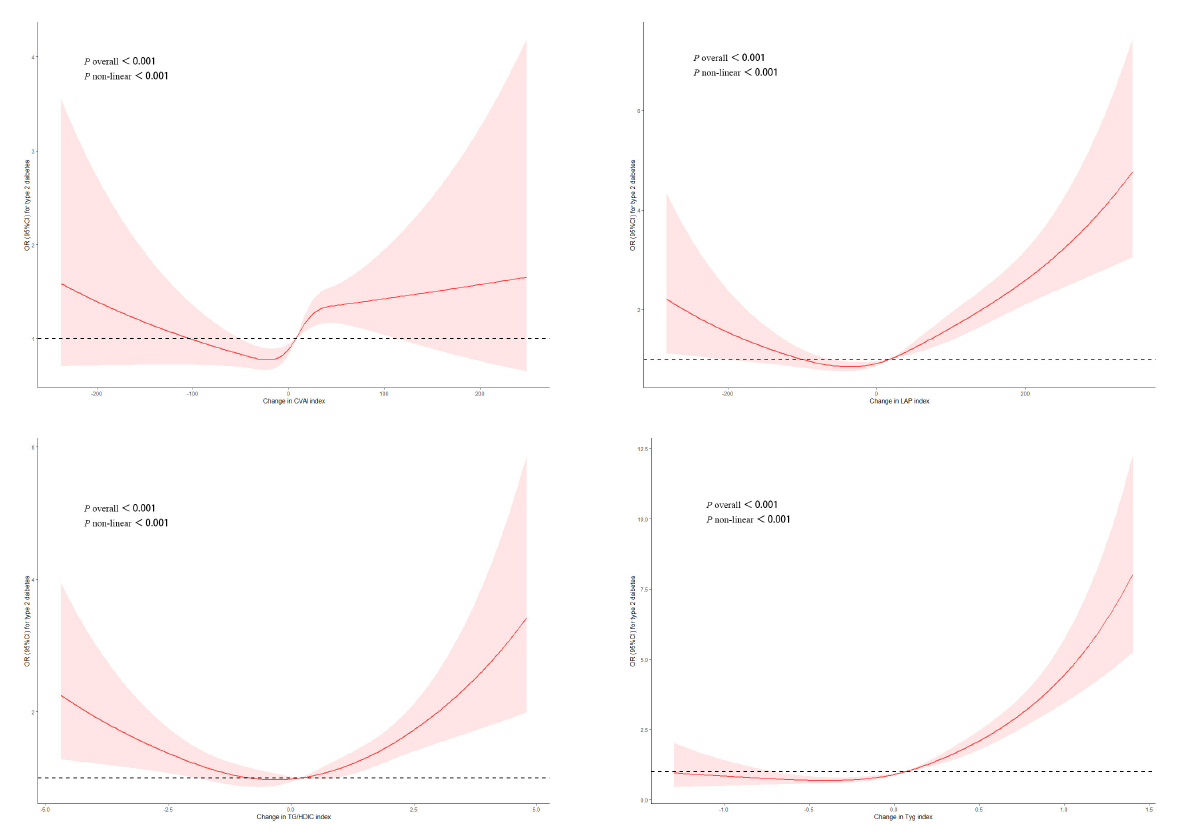
FIGURE1 Adjusted cubic spline model of the relationship between four surrogate indexes and T2DM risk. A U -shaped association between four surrogate IR indexes and the risk of T2DM.